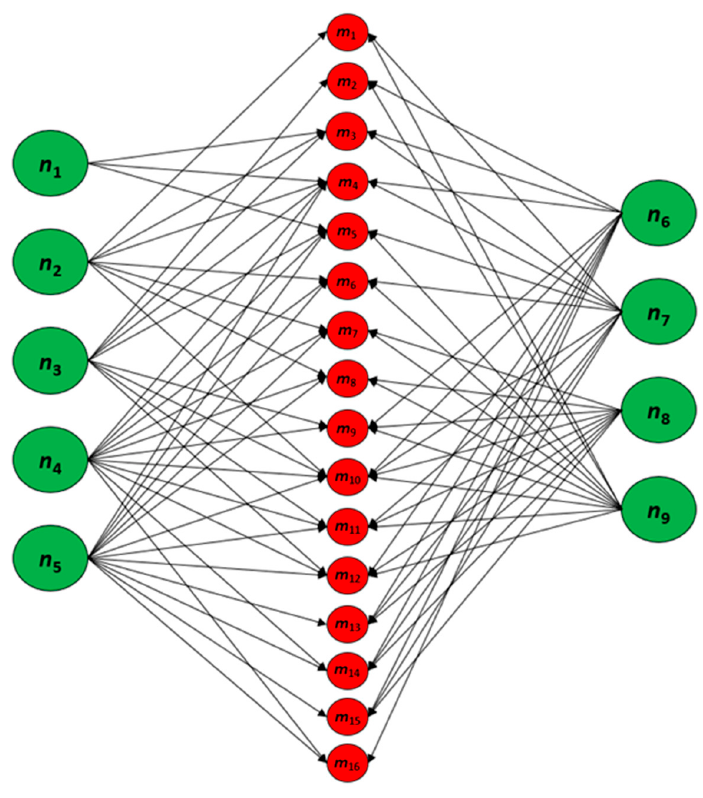
Figure 7. Graphical interpretation of the solution for Variant #1.